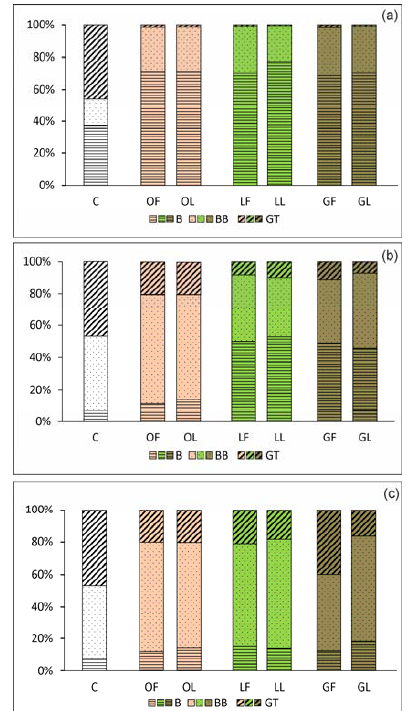
Figure 4. Percentage of C. albicans ATCC 10231 morphological forms (B, blastospores; BB, budding blastospores; GT, germ-tube-positive cells) after 1 ( a ), 2 ( b ), and 3 h ( c ) exposure to SBT fractions at 0.5 × MIC. C. albicans cell morphology was examined by light microscopy (400 × magnification) at these time points. The results are expressed as the proportion ± S.D. of each morphotype after SBT treatment, compared to control C. albicans , assessing 500